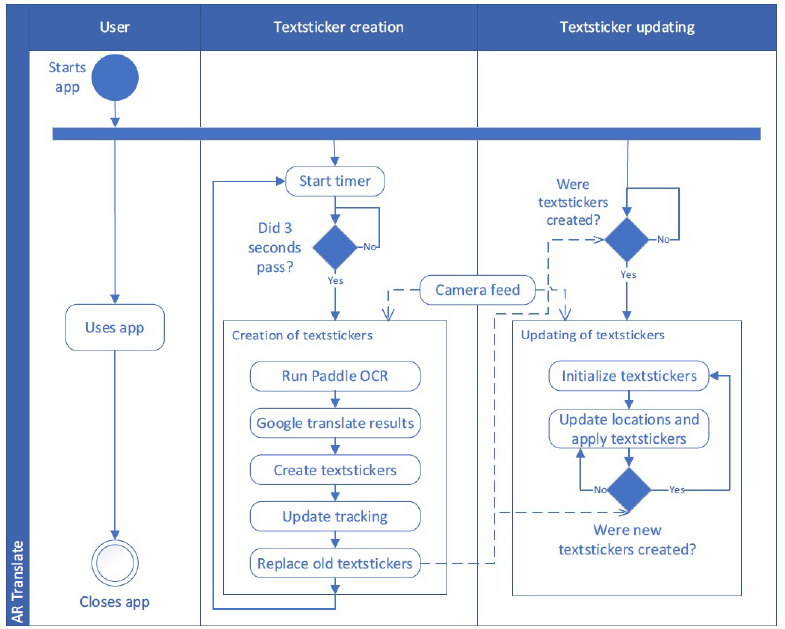
Figure 1. Activity diagram for the implemented AR translator showing the user activity, the creation of text stickers, and the updating of the text stickers. The attentional state of the user was is not supplied